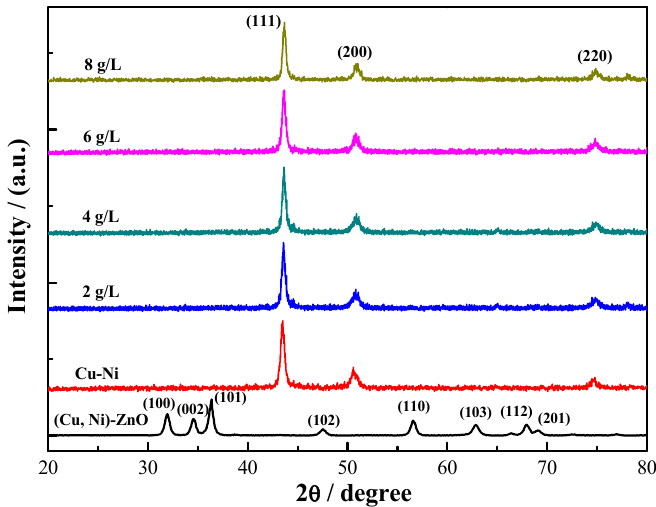
Figure 1. XRD patterns of the (Cu, Ni)-ZnO nanopowder and Cu-Ni-ZnO nanocomposite coatings.